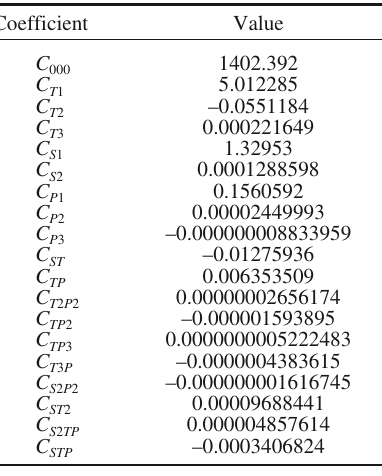
Table 3. – Coefficients used in Equations 1.1 to